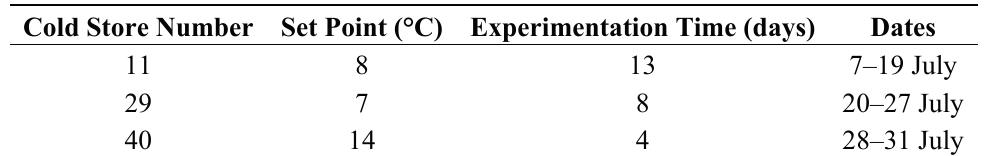
Table 1. Experimental